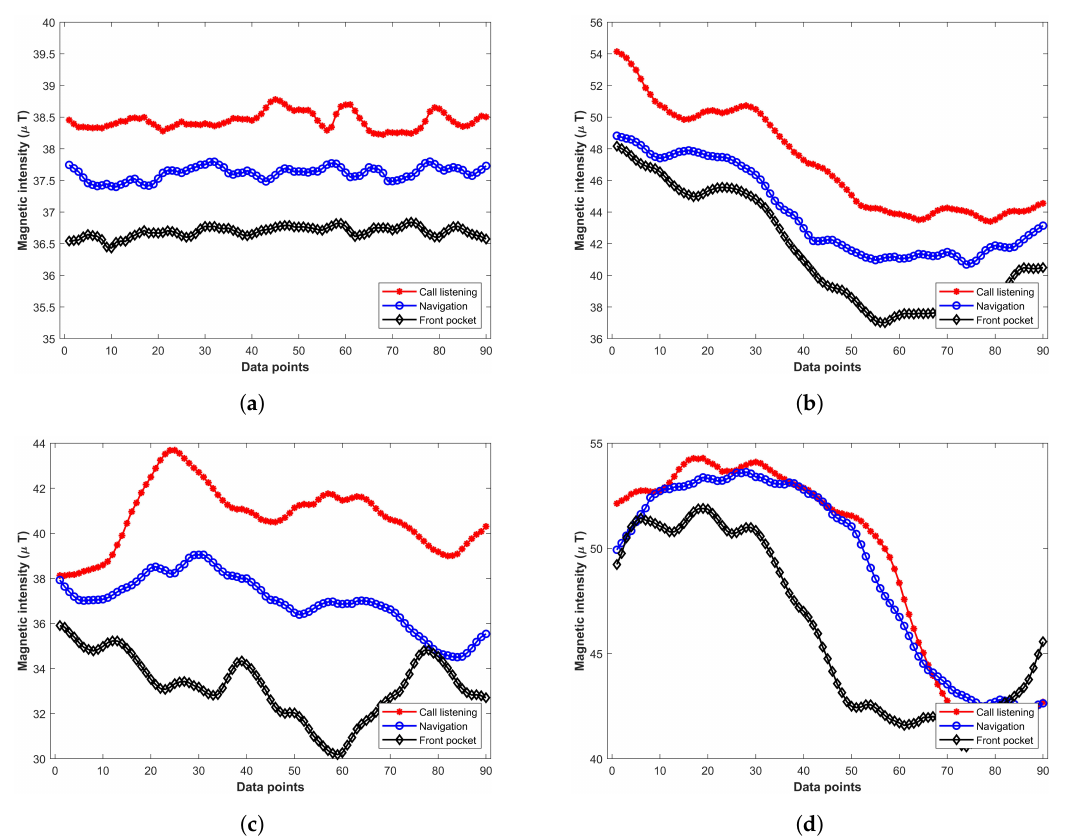
Figure 2. Magnetic readings with various attitudes of device at different places, ( a ) Location 1; ( b ) Location 2; ( c ) Location 3; ( d ) Location